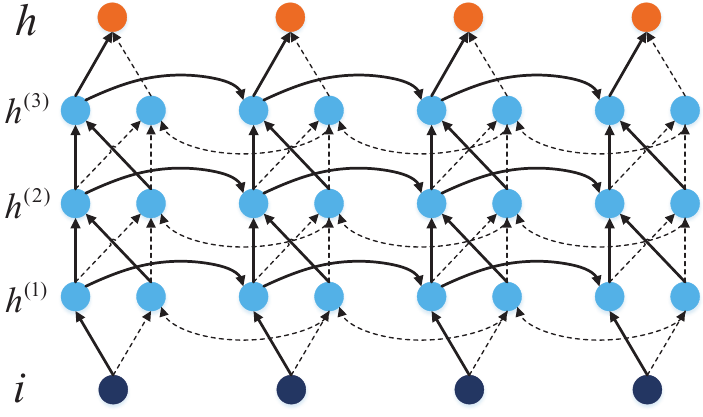
Figure 4. The structure of the three-layer BiGRU